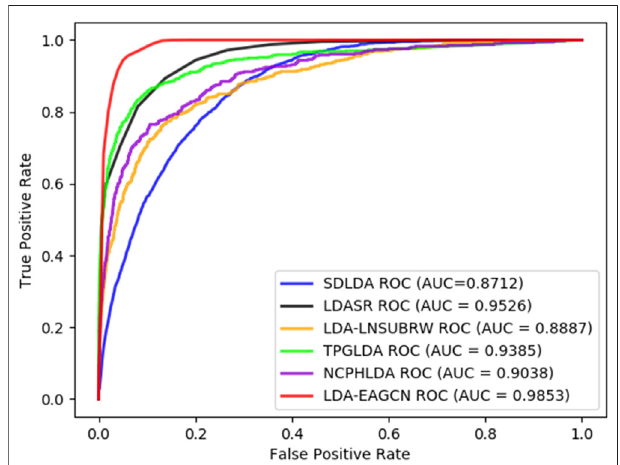
FIGURE 6 | ROC curves of all the models in comparison.